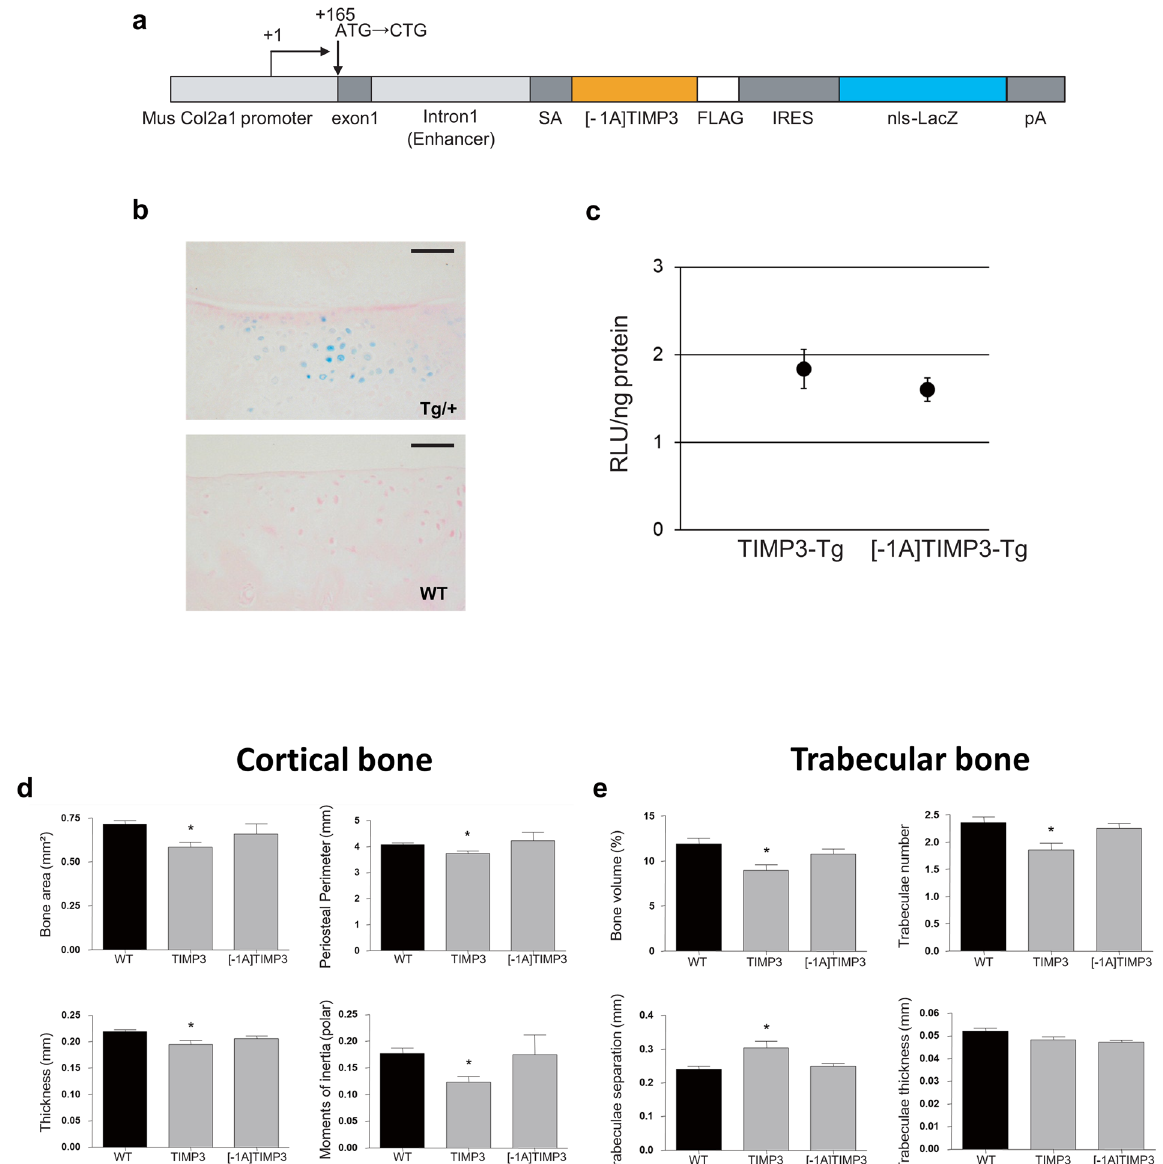
Figure 1. Generation of [-1A]TIMP3 transgenic mice. ( a ) Schematic representation of the construct used to generate transgenic mice. Collagen 2 α 1 chain (Col 2a1) proximal promoter region (3000 bp), first exon (237 bp), and first intron (3020 bp) were used to induce the expression of human [-1A]TIMP3 with a FLAG epitope tag, an IRES sequence, and LacZ with a nuclear localizing signal, followed by the bovine growth hormone gene polyadenylation signal (bpA). ( b ) X-gal staining of the knee joints of the [-1A]TIMP3 heterozygotes mice (upper panel, Tg/ + ) or non-transgenic wild-type mice (lower panel, WT) at 2 weeks of age. Bars, 50 μ m. ( c ) Comparison of transgenic expression by determining β -galactosidase activity in TIMP3 heterozygotes (n = 5, line 19) and [-1A]TIMP3 heterozygotes (n = 7, line 7). Values represent the mean ± SEM. ( d) Data generated from µ CT scans of isolated tibia at 18 weeks of age from non-transgenic mice (WT, n = 17), TIMP3 heterozygous mice (n = 9), and [-1A]TIMP3 heterozygous mice (n = 9) for the cortical bone and ( d ) for the trabecular bone. Bars, 200 μ m. ( e ) Values represent the mean ± SEM. * Indicates significance (p < 0.05) compared to wild-type mice (one-way ANOVA and Dunnett’s